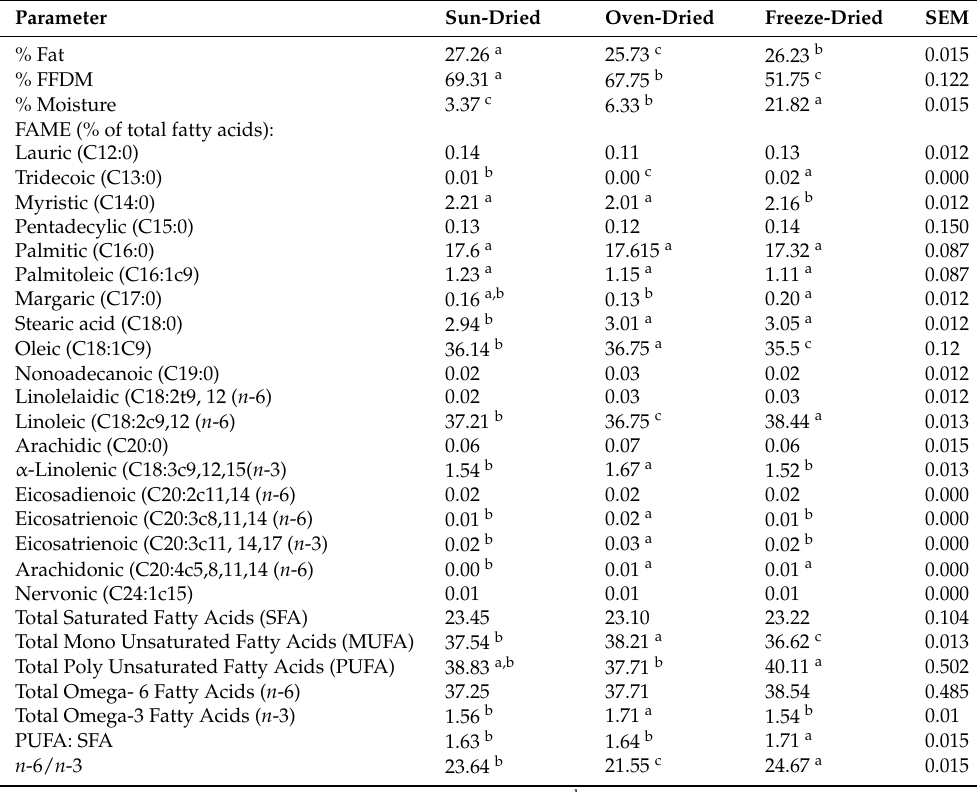
Table 5. Fatty acids profile of oven-dried, sun-dried and freeze-dried mealworm larvae. Parameter